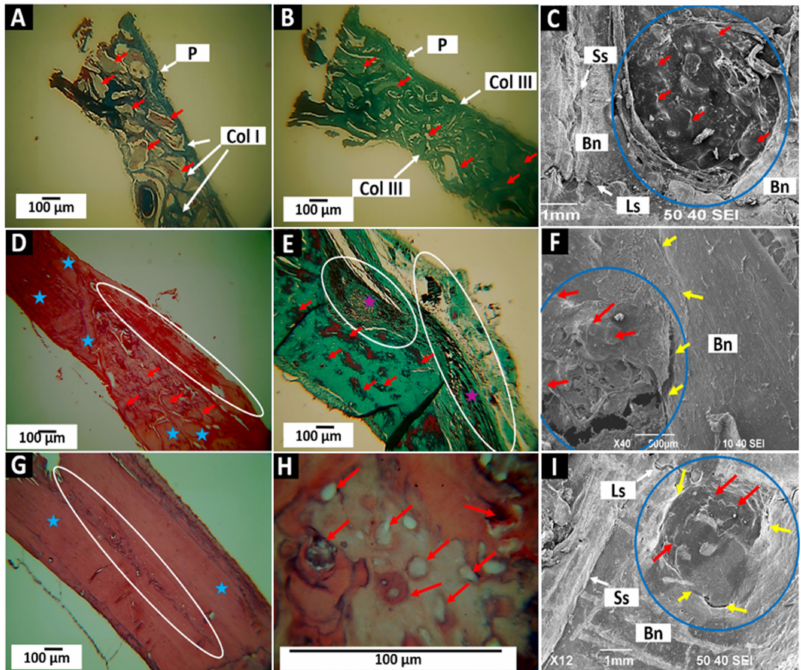
Figure 8. F1 material (InterOss) implanted in cranial bones. ( A ): Implantation at 30 days at 10 × . Masson’s Trichrome (MT) technique. ( B ): Implantation at 30 days at 10 × . Gomori’s (GT) tech- nique. ( C ): Implantation at 30 days at 12 × . SEM technique. ( D ): Implantation at 60 days at 10 × . Hematoxylin—Eosin (HE) technique. ( E ): Implantation at 60 days at 10 × . GT technique. ( F ): Im- plantation at 60 days at 40 × . SEM technique. ( G ): Implantation at 90 days at 10 × . HE technique. ( H ): Implantation at 90 days at 100 × . HE technique. ( I ): Implantation at 90 days at 12 × . SEM technique. P: Periosteum. Col I: Type I Collagen. Col III: Type III collagen. Ss: sagittal suture. Ls: lambdoid suture. Bn: bone. Blue stars: bone tissue in formation. Yellow arrows: Interface preparation—Bone. Red arrows: Remaining InterOss material. White oval: Areas with the remaining material. Blue circles: implantation